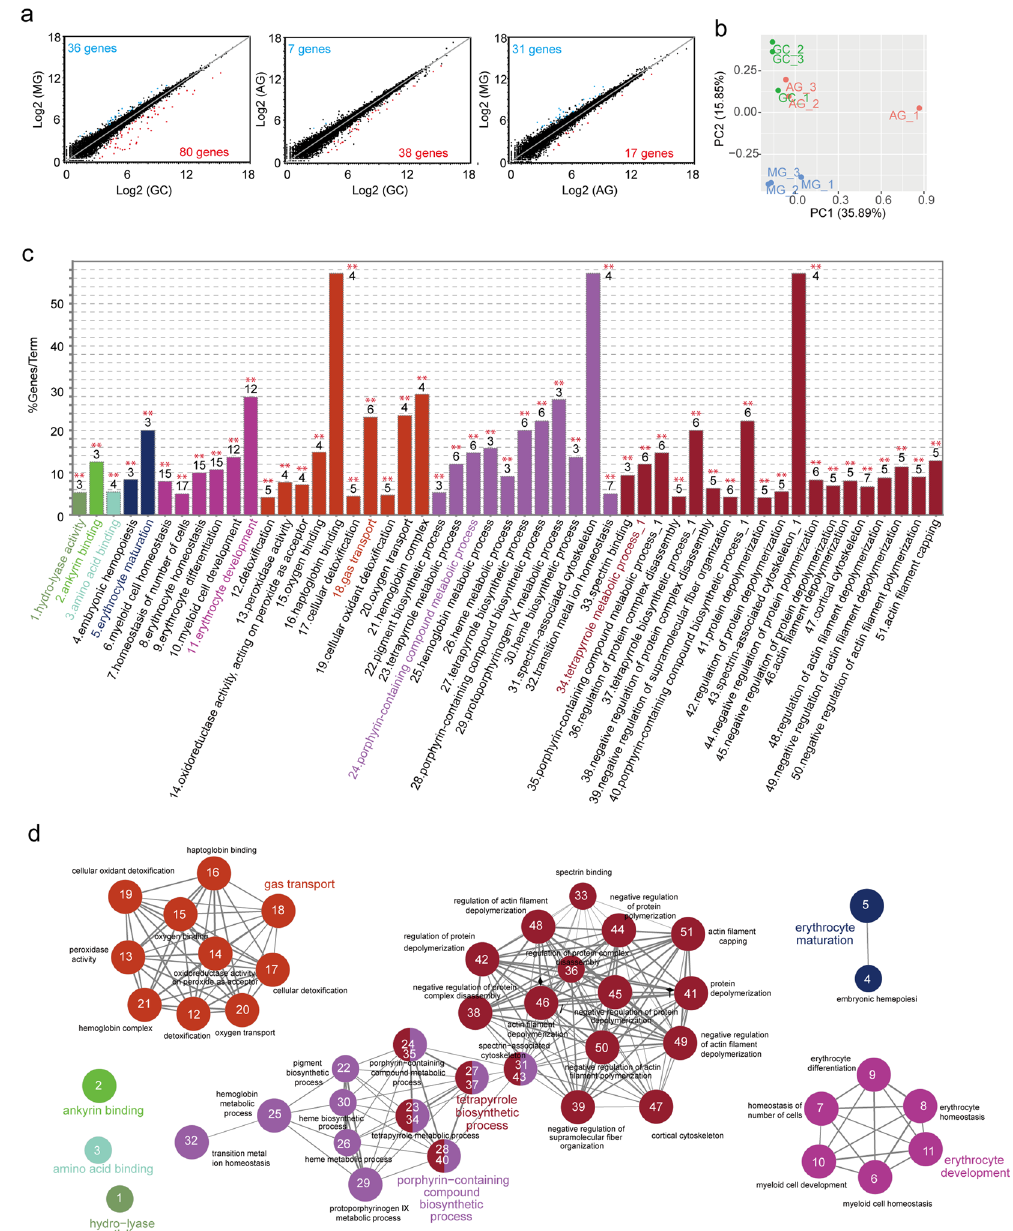
Figure 2. Down-regulation of erythrocyte-related genes in the spleen by spaceflight. ( a ) Scatter plots of RNA-Seq data. Each axis shows log2 of average gene expression values, which were normalized using the CLC Main Workbench (Qiagen). GC: ground control mice; MG: mice flown in the ISS; AG: mice receiving 1 G by centrifugation in the ISS. Significantly up- and down-regulated genes (FDR P-value < 0.05 and fold change >± 2 estimated by the EDGE test) are indicated as red and blue dots, respectively. ( b ) PCA analysis of gene expression in the spleen of MG (blue), AG (red), and GC (green) mice. ( c ) Gene ontology (GO) enrichment analysis of genes down-regulated in the spleens of MG mice as compared to GC mice. GO terms and percentage of the down-regulated genes among total termed genes are exhibited. Top number of each bar indicates the number of reduced genes in each term. ** P < 0.01, Two-sided hypergeometric test corrected with Bonferroni step down. ( d ) Clusters of GO terms of genes significantly down-regulated in the spleens of MG compared to GC mice. Each circle shows a GO term. A line between circles shows a correlation of two GO terms. A number in each GO term circle corresponds to number of the GO term in ( b